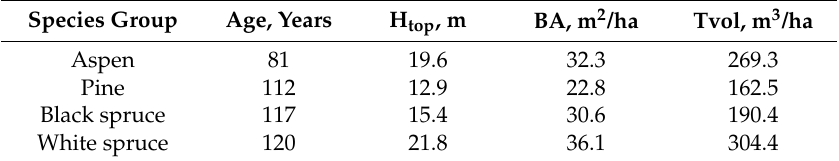
Table 1. Test data set generated from the species-specific mean values for time T1 [1] (Tables 1 and 2). Species Group Age, Years H top , m BA, m 2 /ha Tvol, m 3